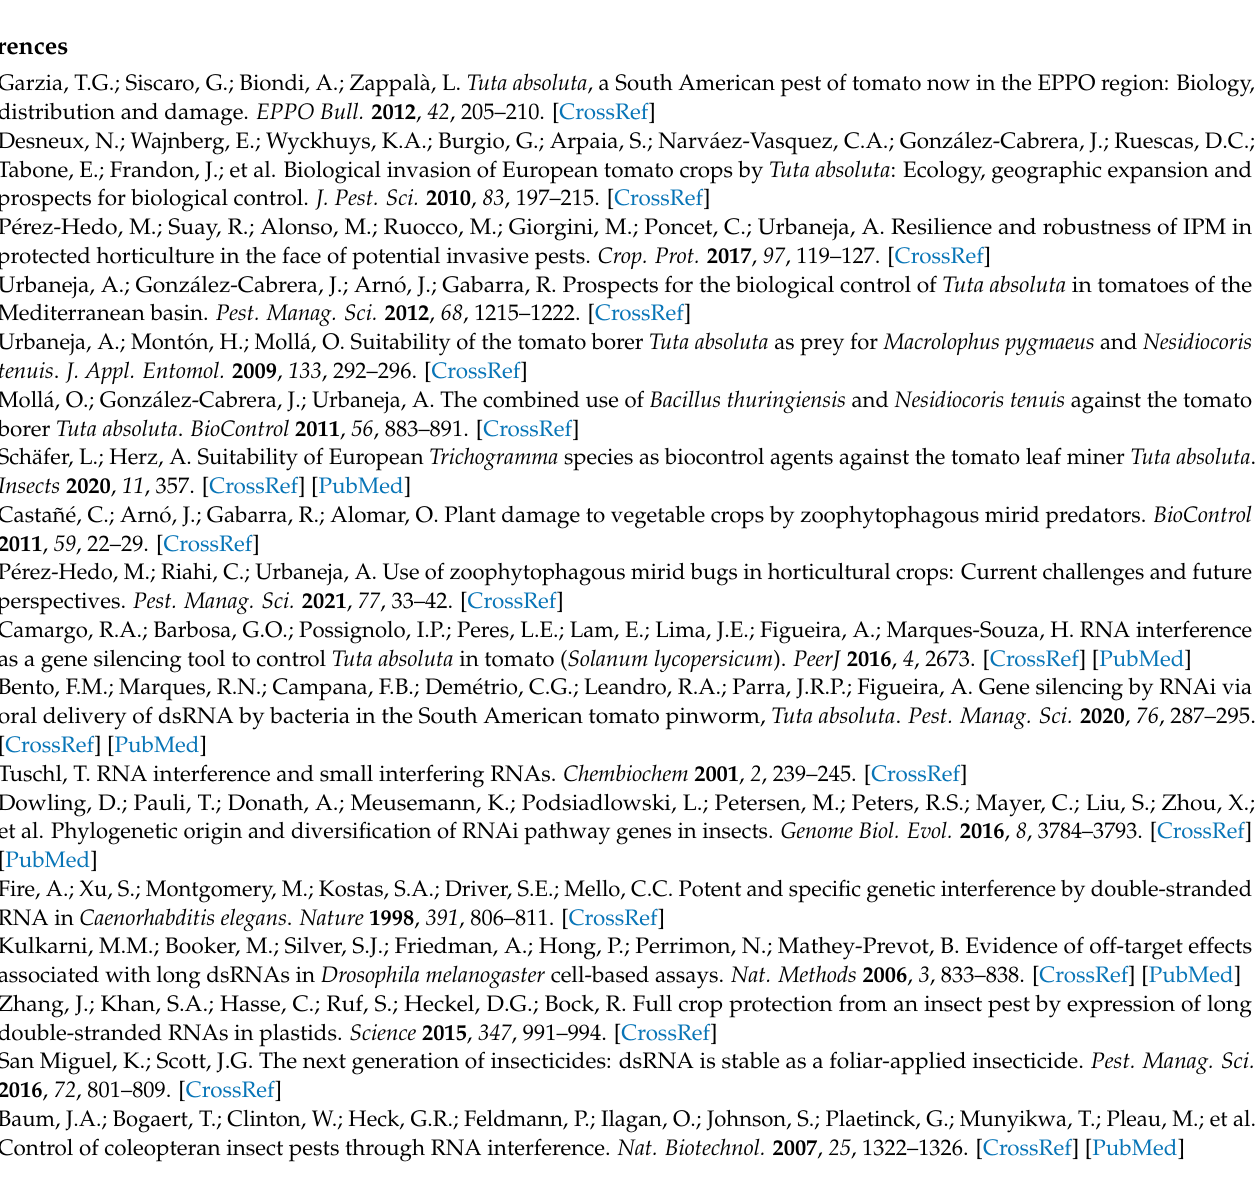
Figure S2: DNA sequence alignment between the region of α COP from T. absoluta used for dsRNA production and the respective region of α COP from N. tenuis